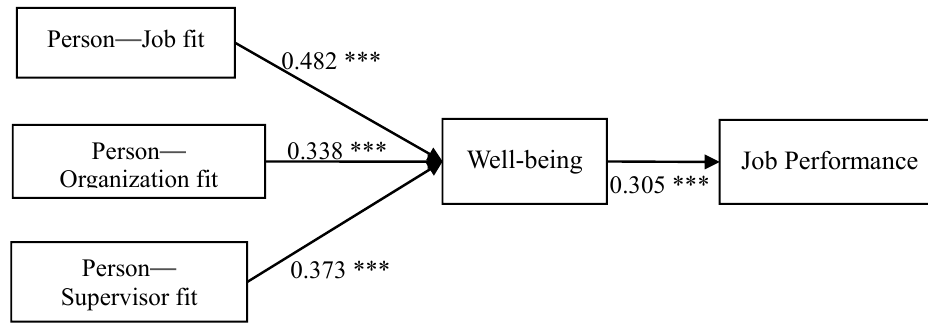
Figure 2. Path analysis results, *** p < 0.001.